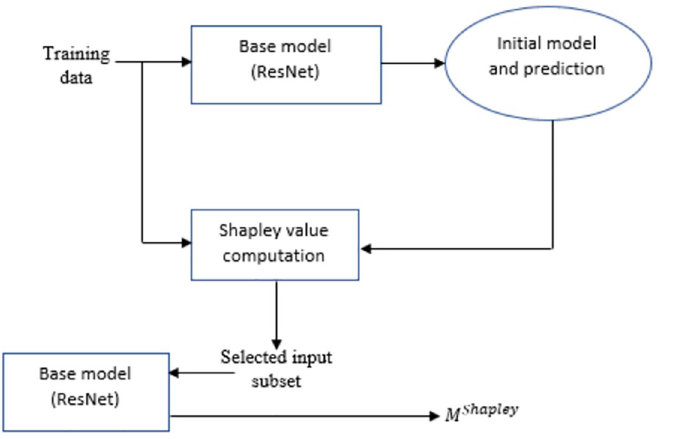
Fig 12. Constructing the Shapley-value ablated model M Shapley .